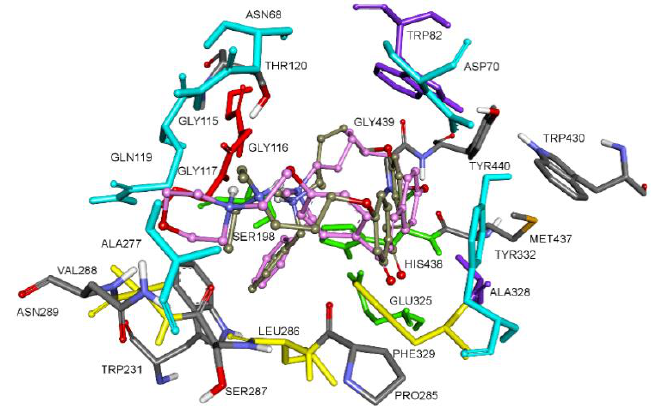
Figure 4. Proposed binding mode for compounds 4 and 6 inside the gorge cavity of h BuChE. Compound 4 is colored olive green. Compound 6 is colored pink. Different subsites of the active site were colored: catalytically anionic site (CAS) in green, oxyanion hole (OH) in red, choline binding site in violet (CBS), acyl binding pocket (ABP) in yellow, and peripheral site (PAS) in blue.